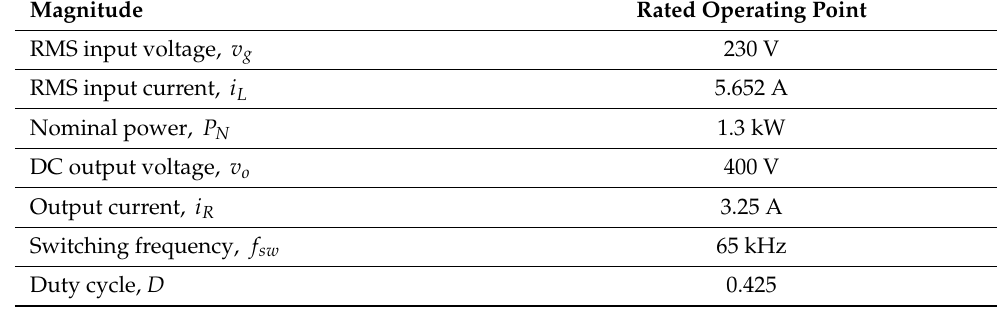
Table 1. Example of technical specifications of the converter.